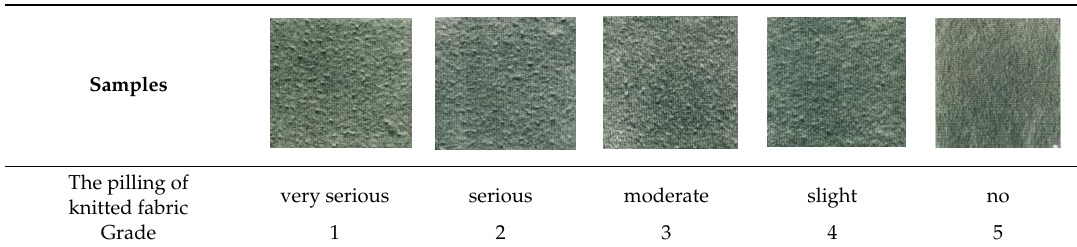
Table 1. Five pilling grades of knitted fabric.